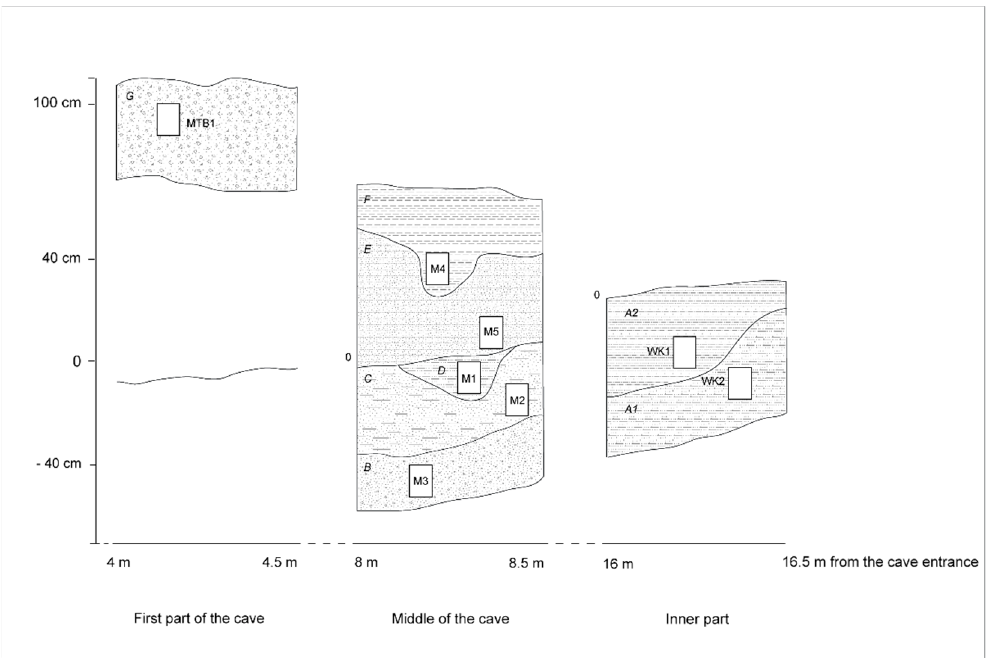
Figure 2. Stratigraphy with the sedimentological layers, as well as sampling locations. The blank portions were not excavated due to the presence of boulders and the absence of original deposits. A1–